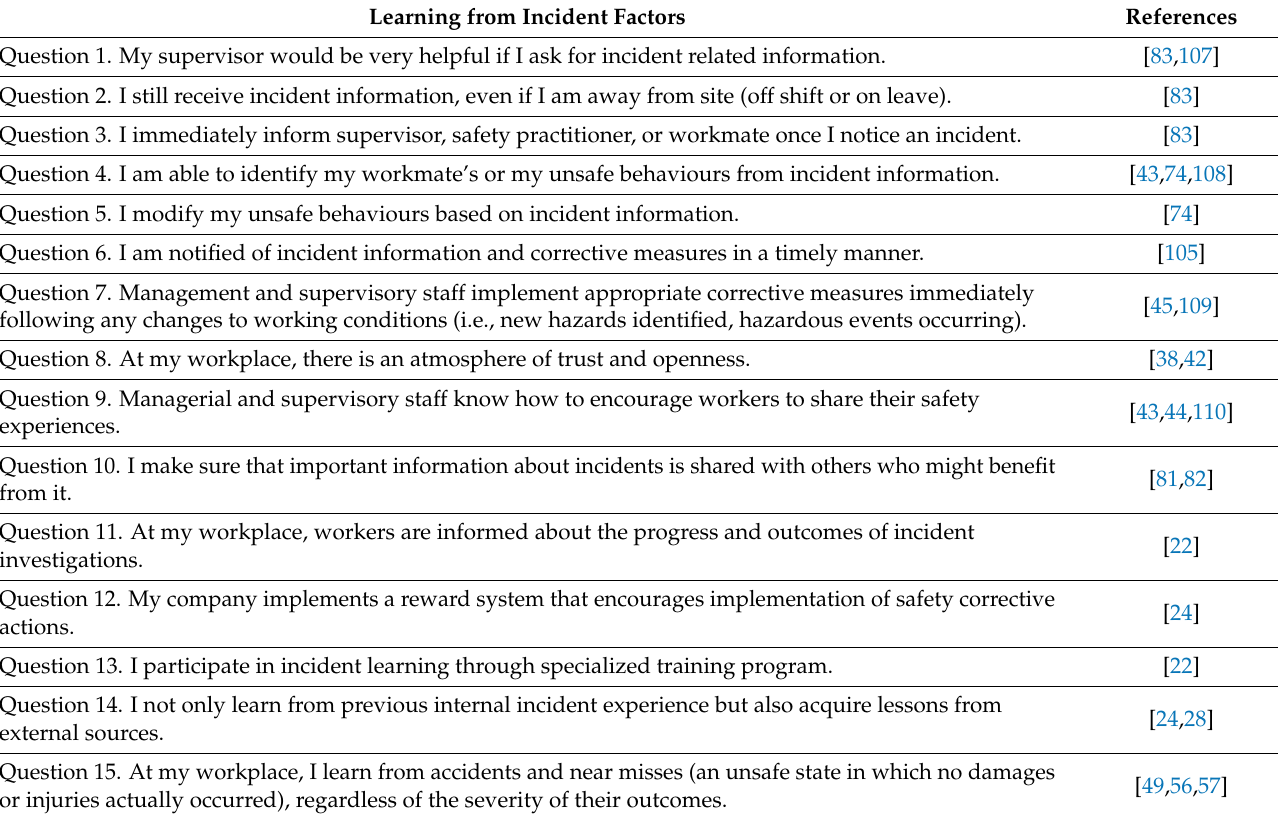
Table 2. Learning from incident